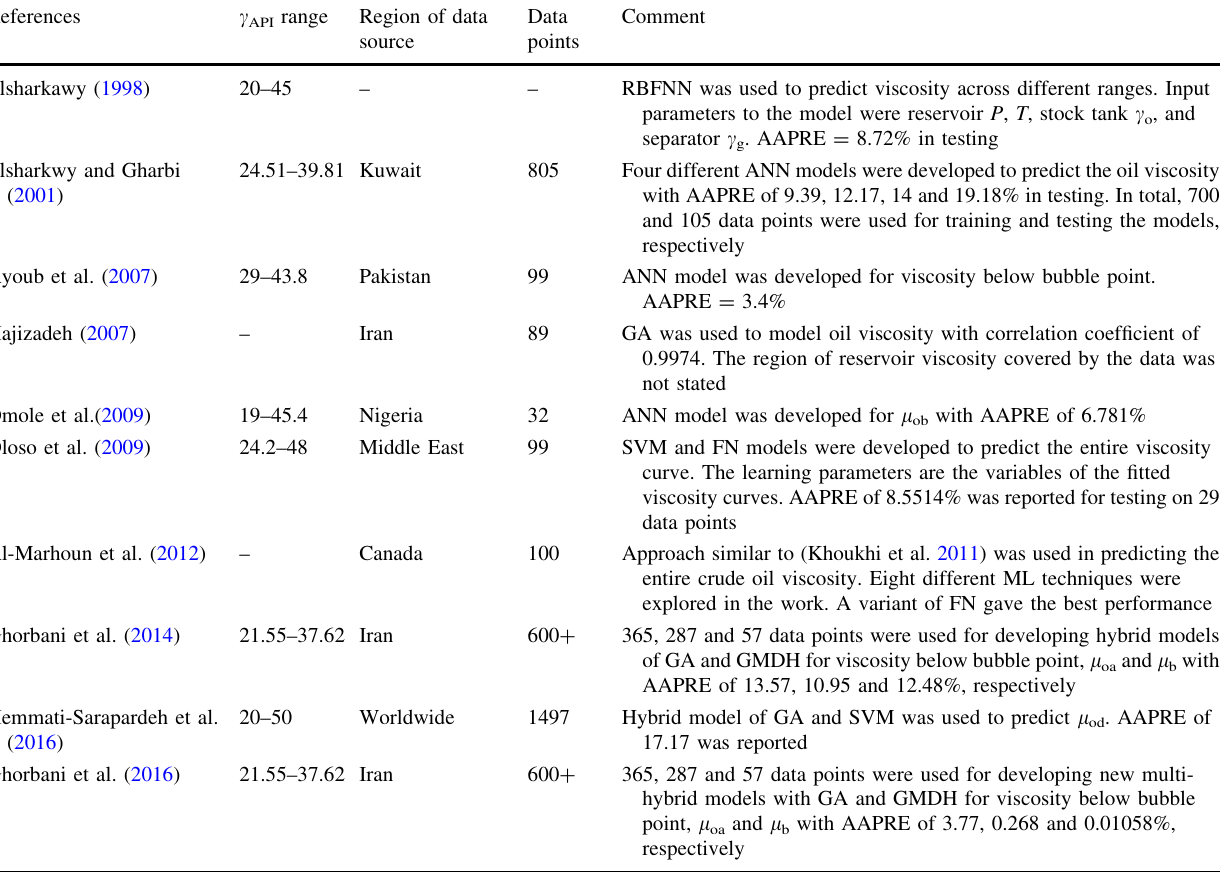
Table 4 Machine learning techniques for viscosity